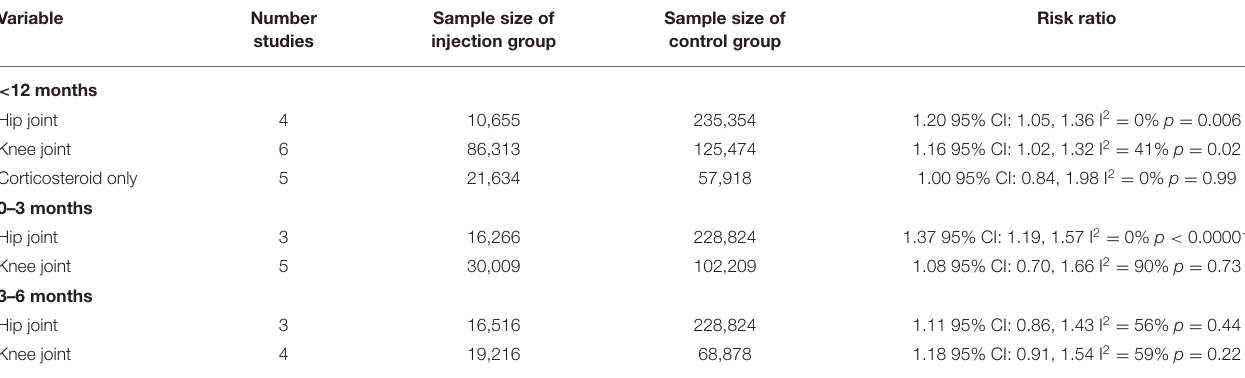
TABLE 2 | Subgroup analysis of PJI for studies reporting time interval between intra-articular injections and surgery.